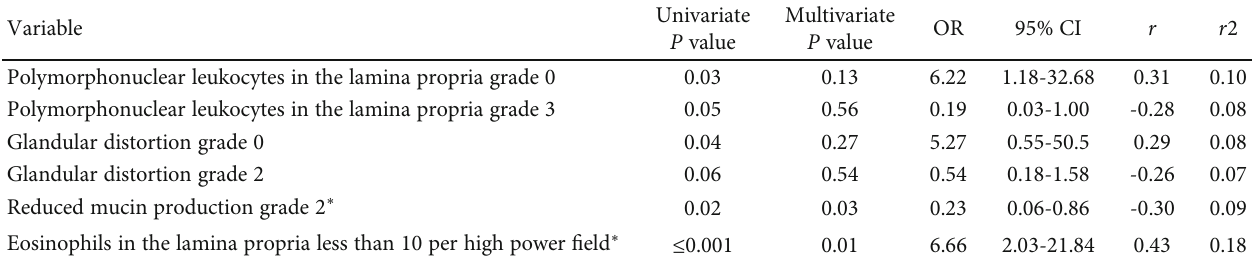
Table 4: Univariate and multivariate analysis for pathologic characteristics at diagnosis associated with histologic remission during follow-up in patients with ulcerative